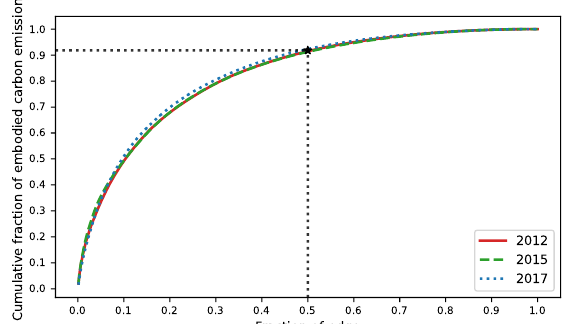
Figure 4. Cumulative fraction of edges by weight.